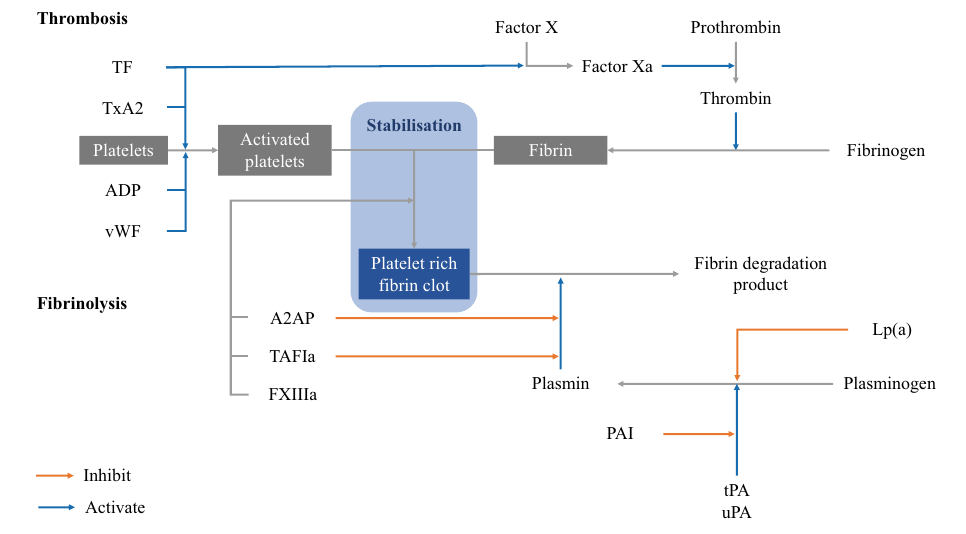
mainly driven by plasmin. The activation of plasmin requires tis- sue (tPA) and urokinase (uPA) plasminogen activator. Inhibitors of